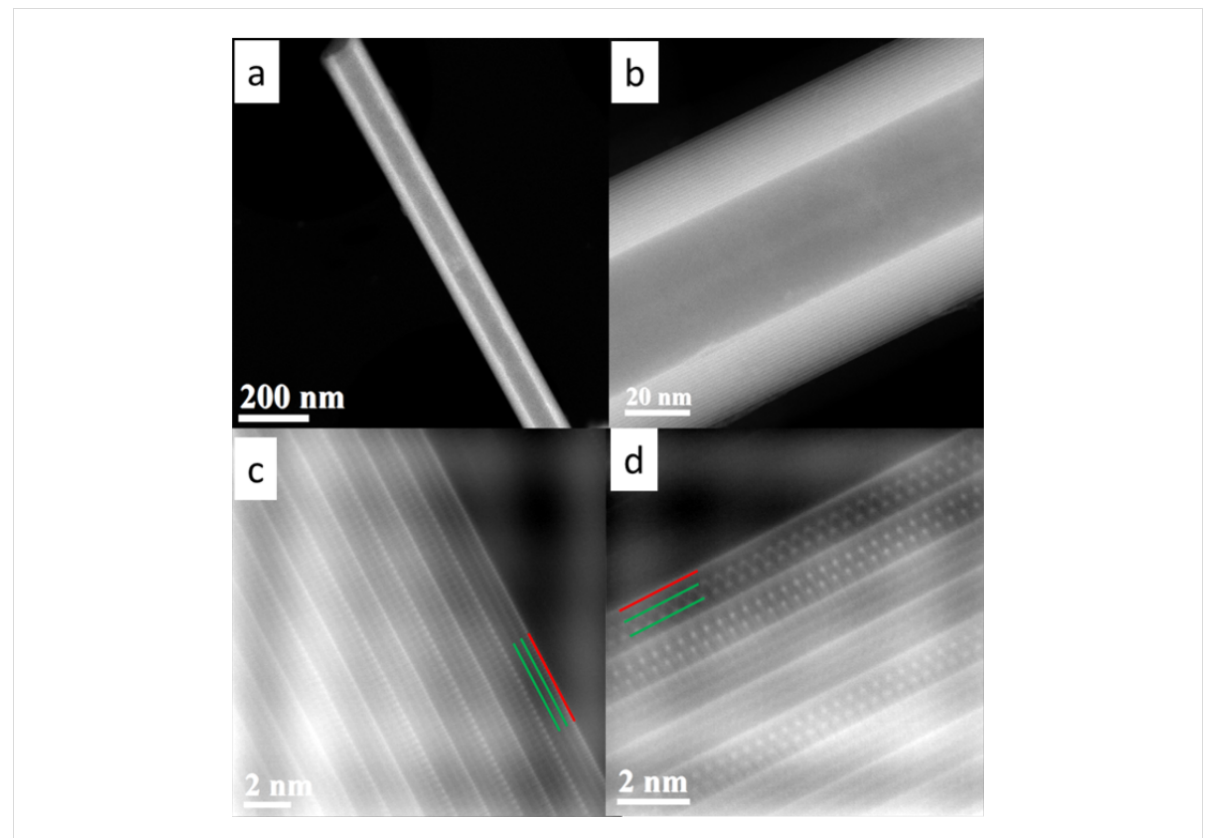
Figure 4: (a), (b) HAADF STEM images of Sr x La 1- x S-TaS 2 (Sr 10 atom %) nanotubes. (c) High-resolution image of (a) indicating that alternating TaS 2 layers (red line) are of two different orientations. (d) High-resolution image of (b) showing the Sr x La 1- x S double layer clearly (two atomic planes indi- cated by green